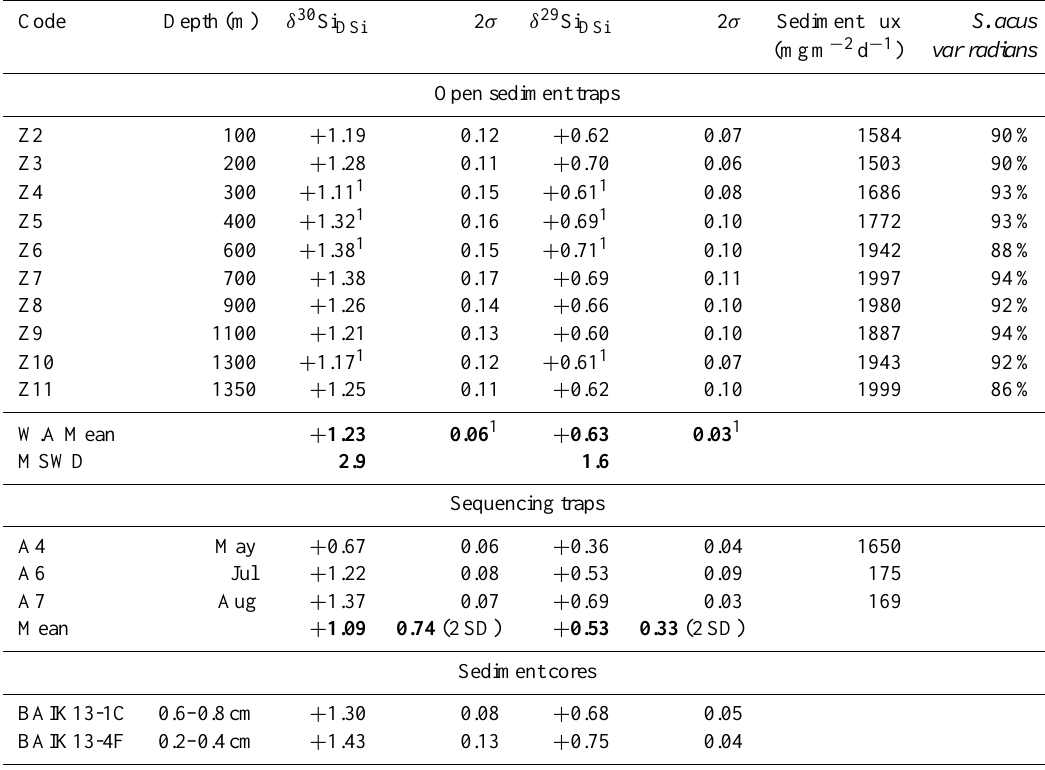
Table 2. Open and sequencing trap (sampling interval 2012–2013) δ 30 Si diatom data and respective uncertainties (2 σ , unless otherwise stated). Mean values for open trap δ 30 Si diatom compositions are provided (in bold) along with 95% confidence and the population MSWD value. Mean values for sequencing trap δ 30 Si diatom are also displayed in bold, with respective 2 SD errors. Respective water column depths for open traps are presented along with the relative abundance of S. acus var radians (data not available for sequencing traps). All open trap data (Z2–Z11) are plotted in Fig.